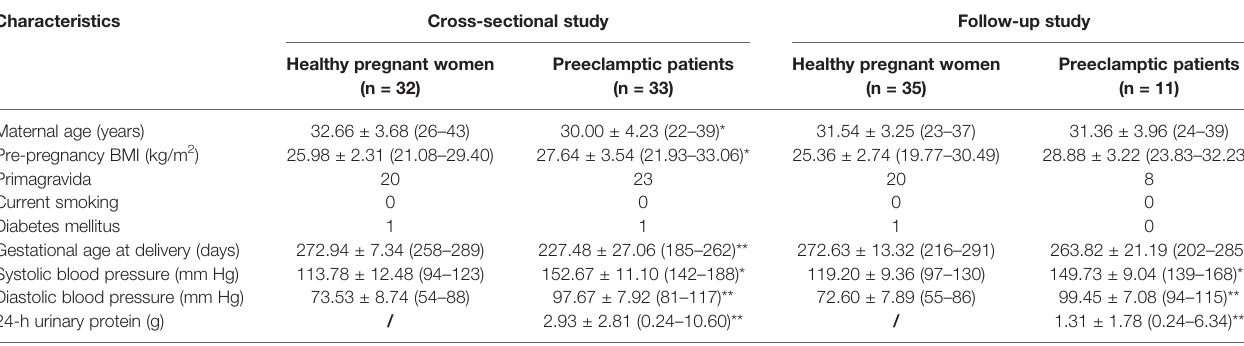
TABLE 1 | Clinical characteristics of cross-sectional study